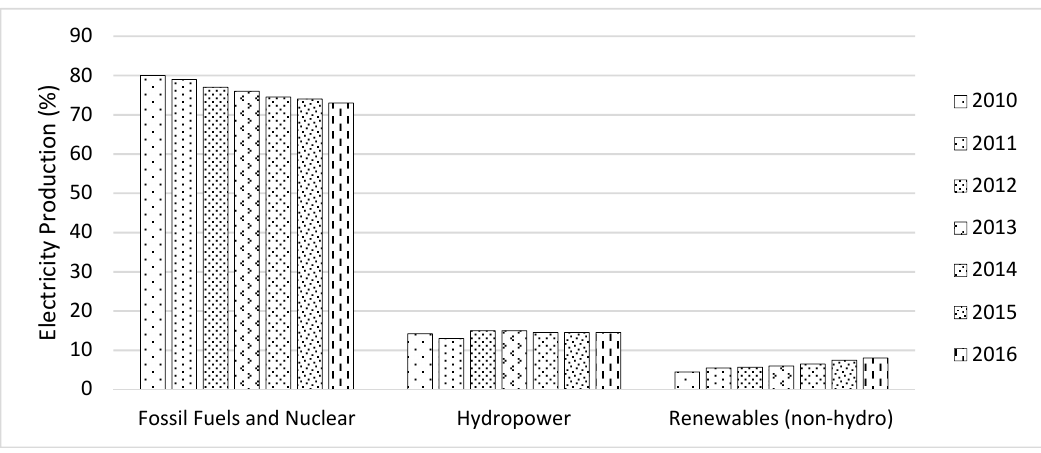
Figure 7. Worldwide electricity production for the period 2010–2016.